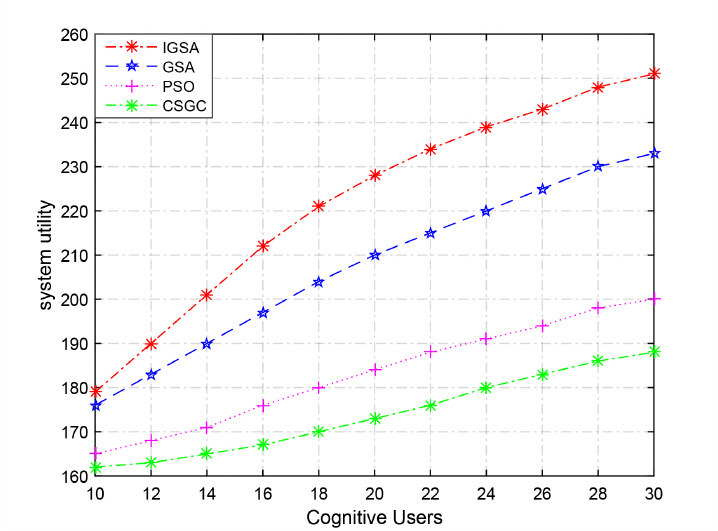
Figure 4. The system utility trend when M =